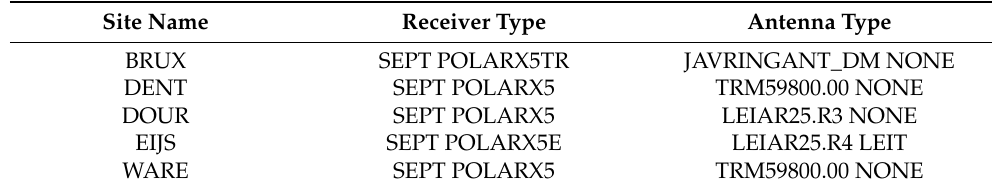
Table 2. Station information of five